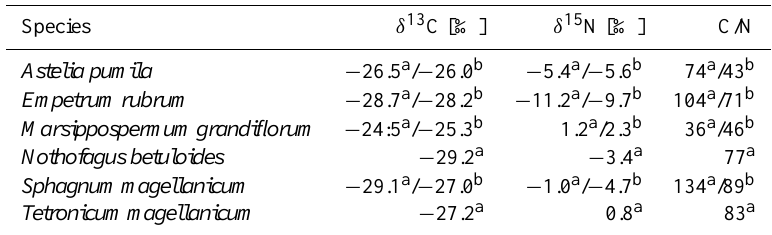
Table 4. Carbon and nitrogen isotope signatures and C/N of different plants of the SkyI site in comparison to values evaluated by Kleinebecker et al. (2009) at bogs in southern